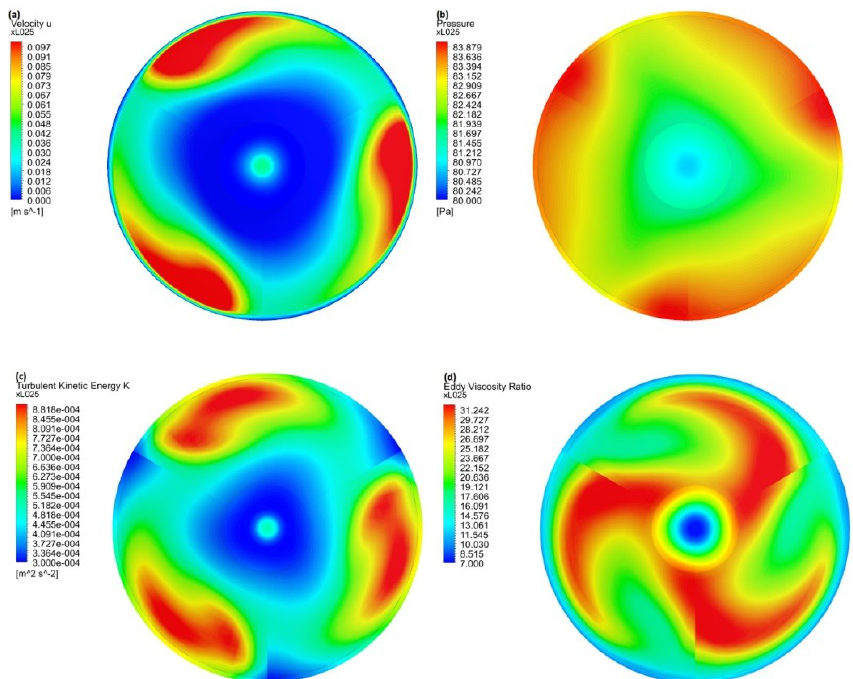
Figure 5. Predicted cross-sectional contours of the mean axial velocity ( a ), the static pressure ( b ), the turbulent kinetic energy ( c ), and the ratio of turbulent to molecular viscosity ( d ). The enhanced levels of turbulence kinetic energy and thus of turbulent mixing due to swirl are evident.